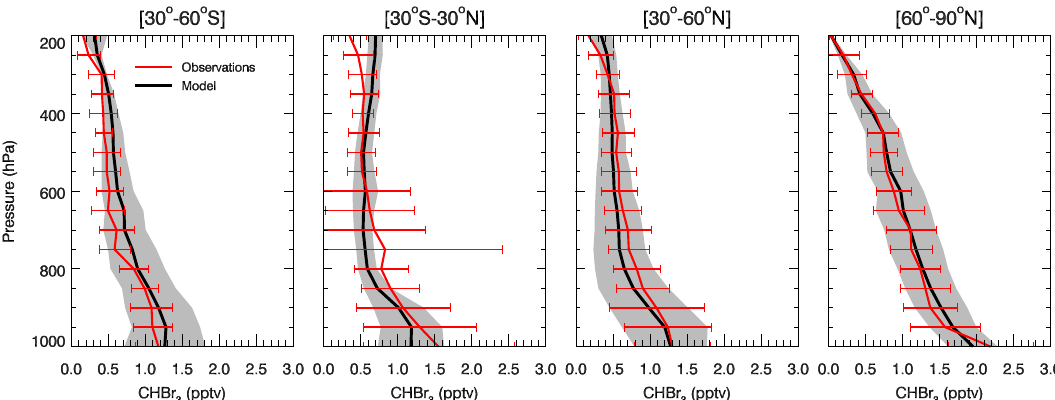
Figure 1. Comparison between the observed (red lines with horizontal bars indicating one standard deviation) and simulated (black lines with gray shading showing one sigma variability) vertical profiles of CHBr 3 in the troposphere. Observations are compiled using whole air sampler canister measurements from eight NASA aircraft missions and are averaged for 30–60 ◦ S, 30 ◦ S–30 ◦ N, 30–60 ◦ N, and 60–90 ◦ N latitude bands at 1km vertical intervals. Model is sampled at the same location as the observations in the corresponding month in 2010.